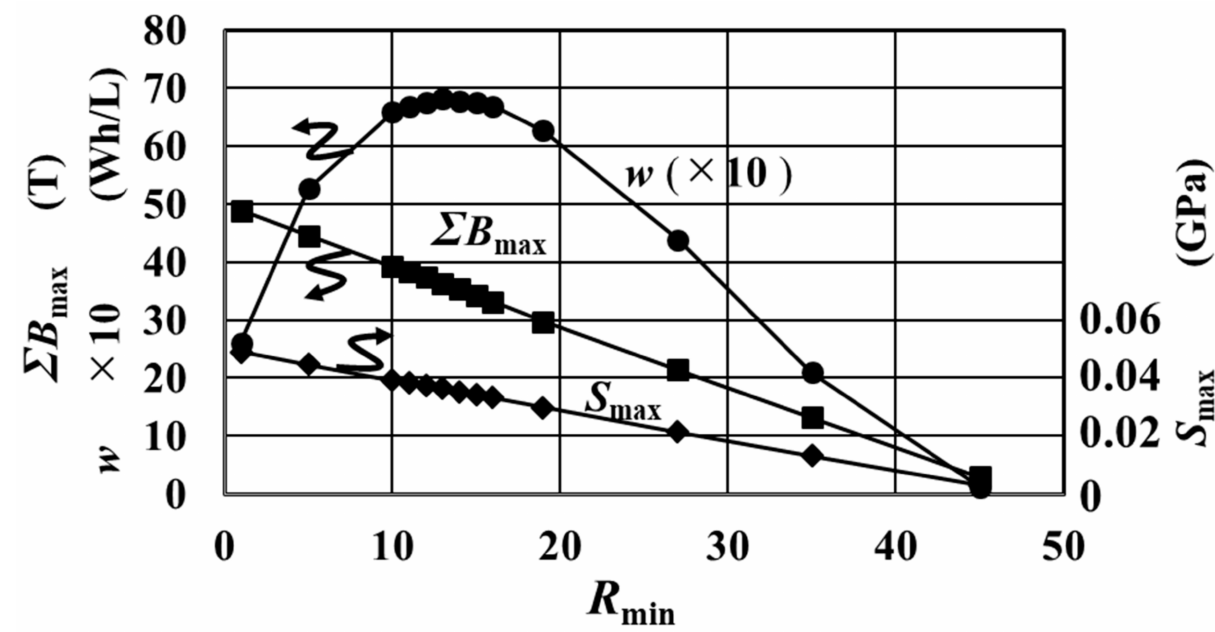
Figure 13. Variations in the electricity storage volume density w , S max , and Σ B max as a function of R min based on the magnetic flux density independent j c = 2 × 10 4 A/mm 2